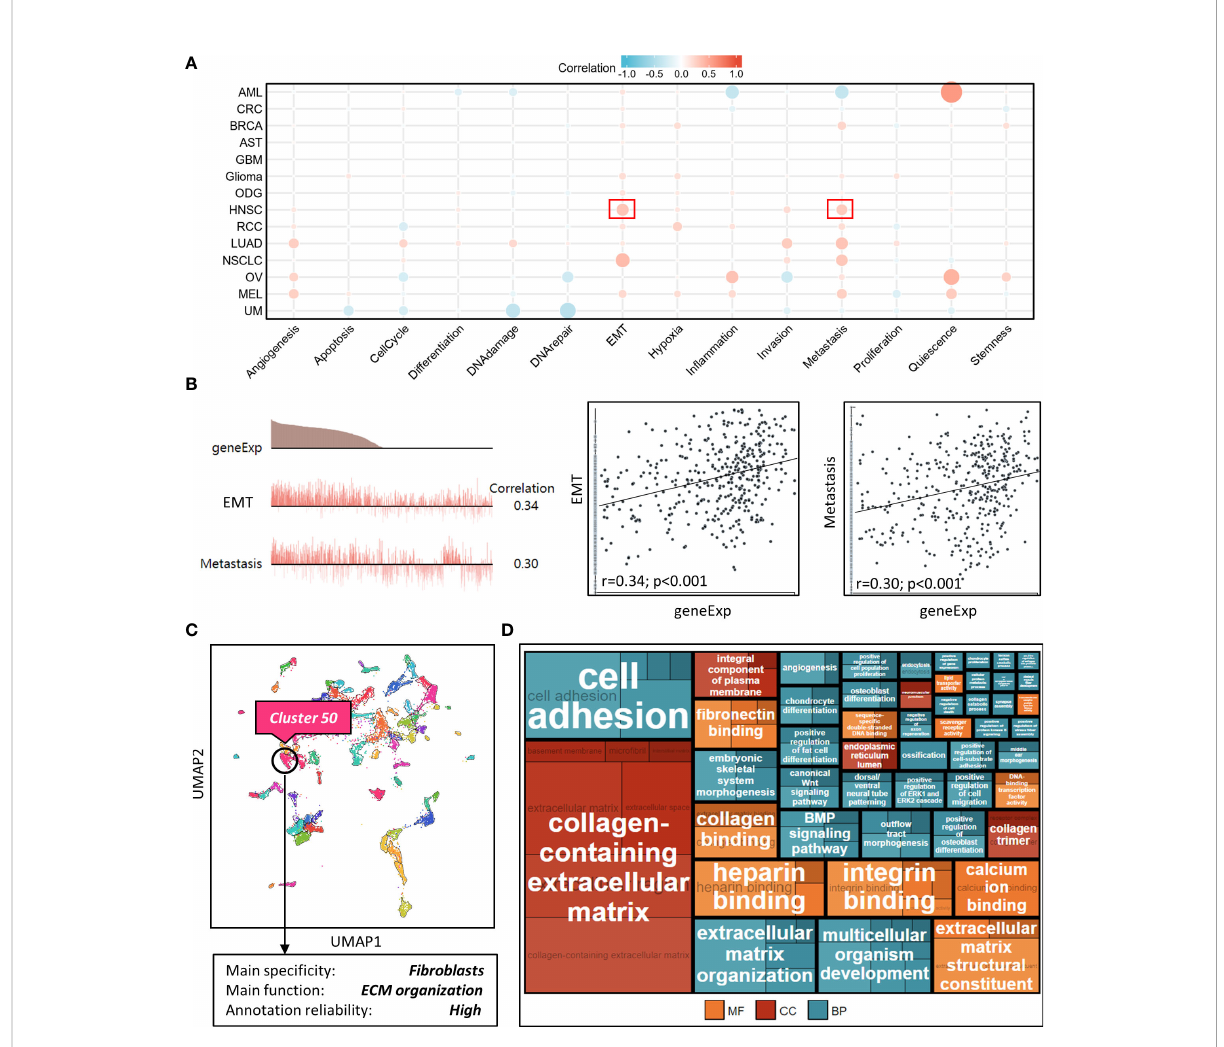
FIGURE 4 Correlation analysis between NT5E and tumor functional status using single cell sequencing database. (A) Heatmap showed the correlation between NT5E expression and different tumor functional status based on the CancerSEA database (Red represents positive correlation and blue represents negative correlation). (B) Correlation between NT5E expression and two different functional states in HNSC [r (EMT)=0.34; p <0.001 and r(Metastasis)=0.30; p <0.001]. (C) NT5E expression analysis using UMAP plot from the HPA database and the main speci fi city of cluster 50 was fi broblasts with ECM organization-related function. (D) Enrichment analysis (MF, CC and BP) of cluster 50 based on the HPA